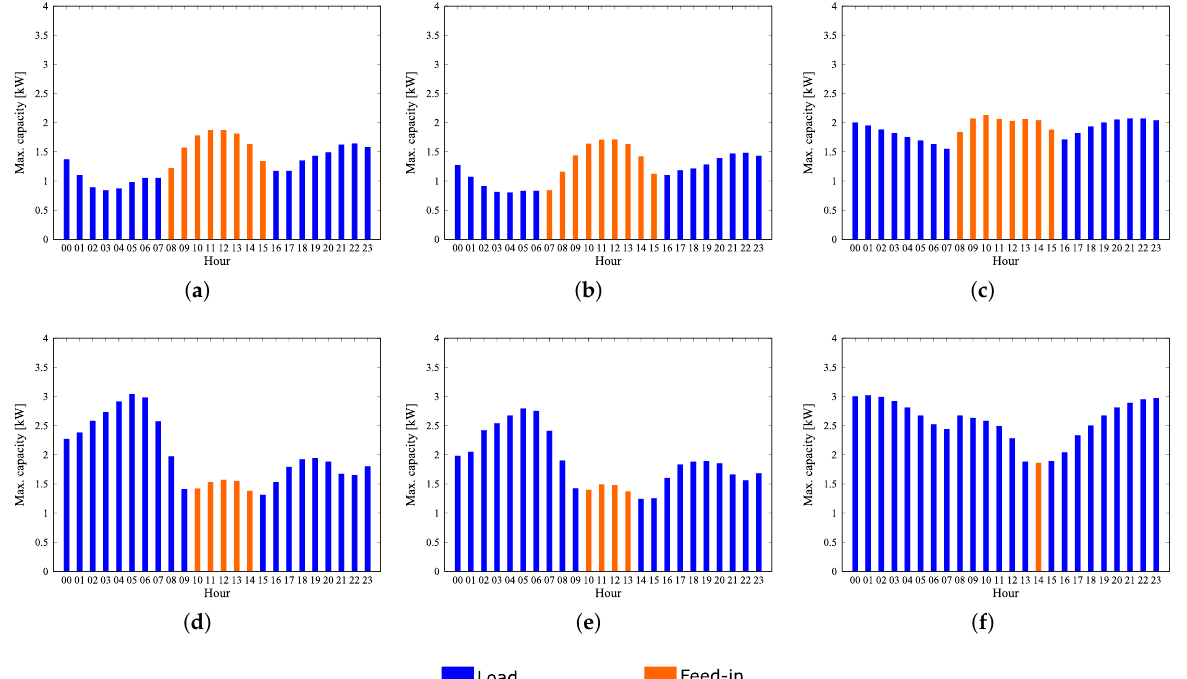
Figure 10. Maximum residual load per hour in a year, per household [kW]. All figures for a distribution network of n = 49 households, i.e., σ = 7. For a 50% prosumer penetration ratio, second line under consideration of widespread e-mobility. ( a ) Battery mode 1, without e-mobility; ( b ) Battery mode 2, without e-mobility; ( c ) Battery mode 3, without e-mobility; ( d ) Battery mode 1, with e-mobility; ( e ) Battery mode 2, with e-mobility; ( f ) Battery mode 3, with